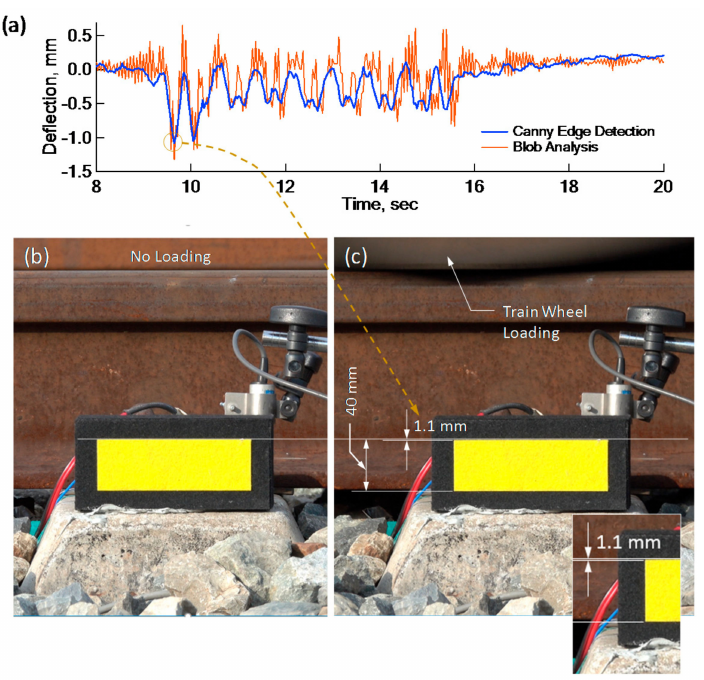
Figure 10. Validity of Canny edge detection technique: ( a ) Comparison of Canny edge technique and